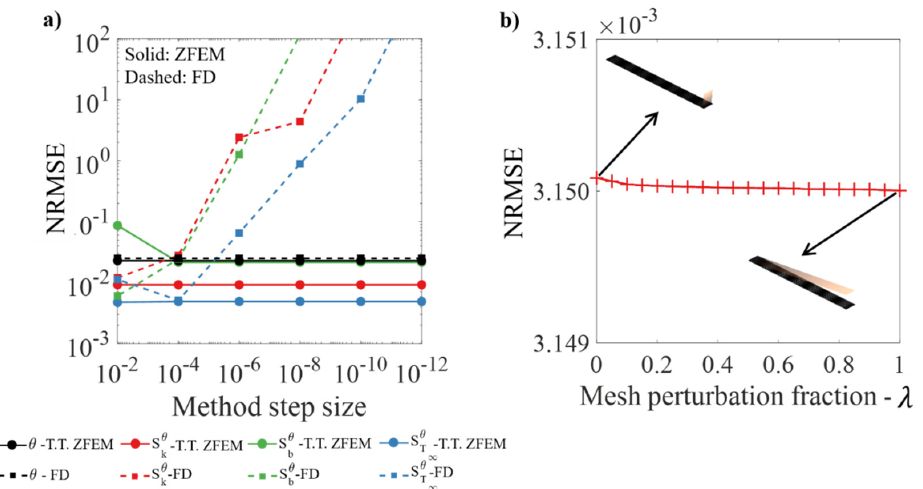
Figure 5. ( a ) Step size convergence analysis comparing Transient Thermal ZFEM and FD for the UEL and the selected analyzed variables. ( b ) Convergence study for mesh perturbation fraction 𝜆 . The insets show 𝑃(𝑥) for the rule of thumb of the literature and 𝜆 = 1 in the top left and bottom right corners, respectively.